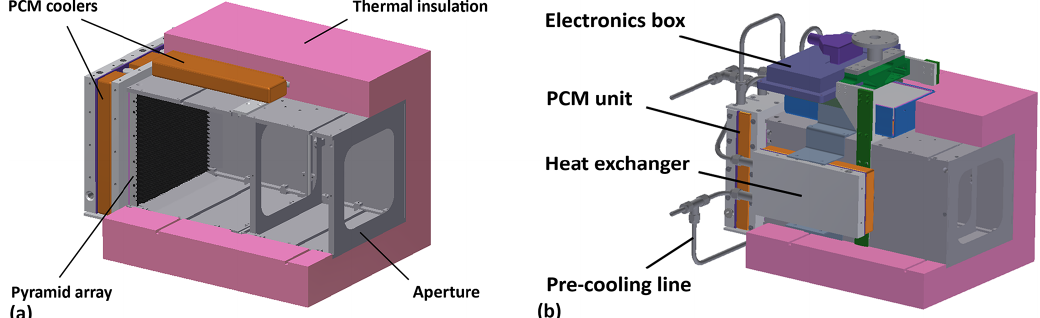
Figure 3. Design of balloon blackbody (a) with electronics and heat exchangers for pre-cooling (b) .